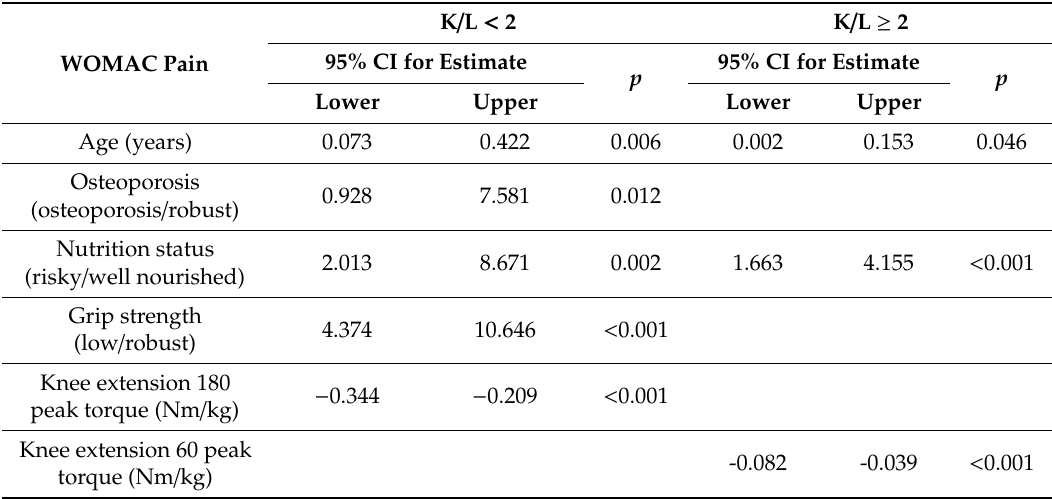
Table 3. Results of stepwise multiple regression analysis for the WOMAC pain.